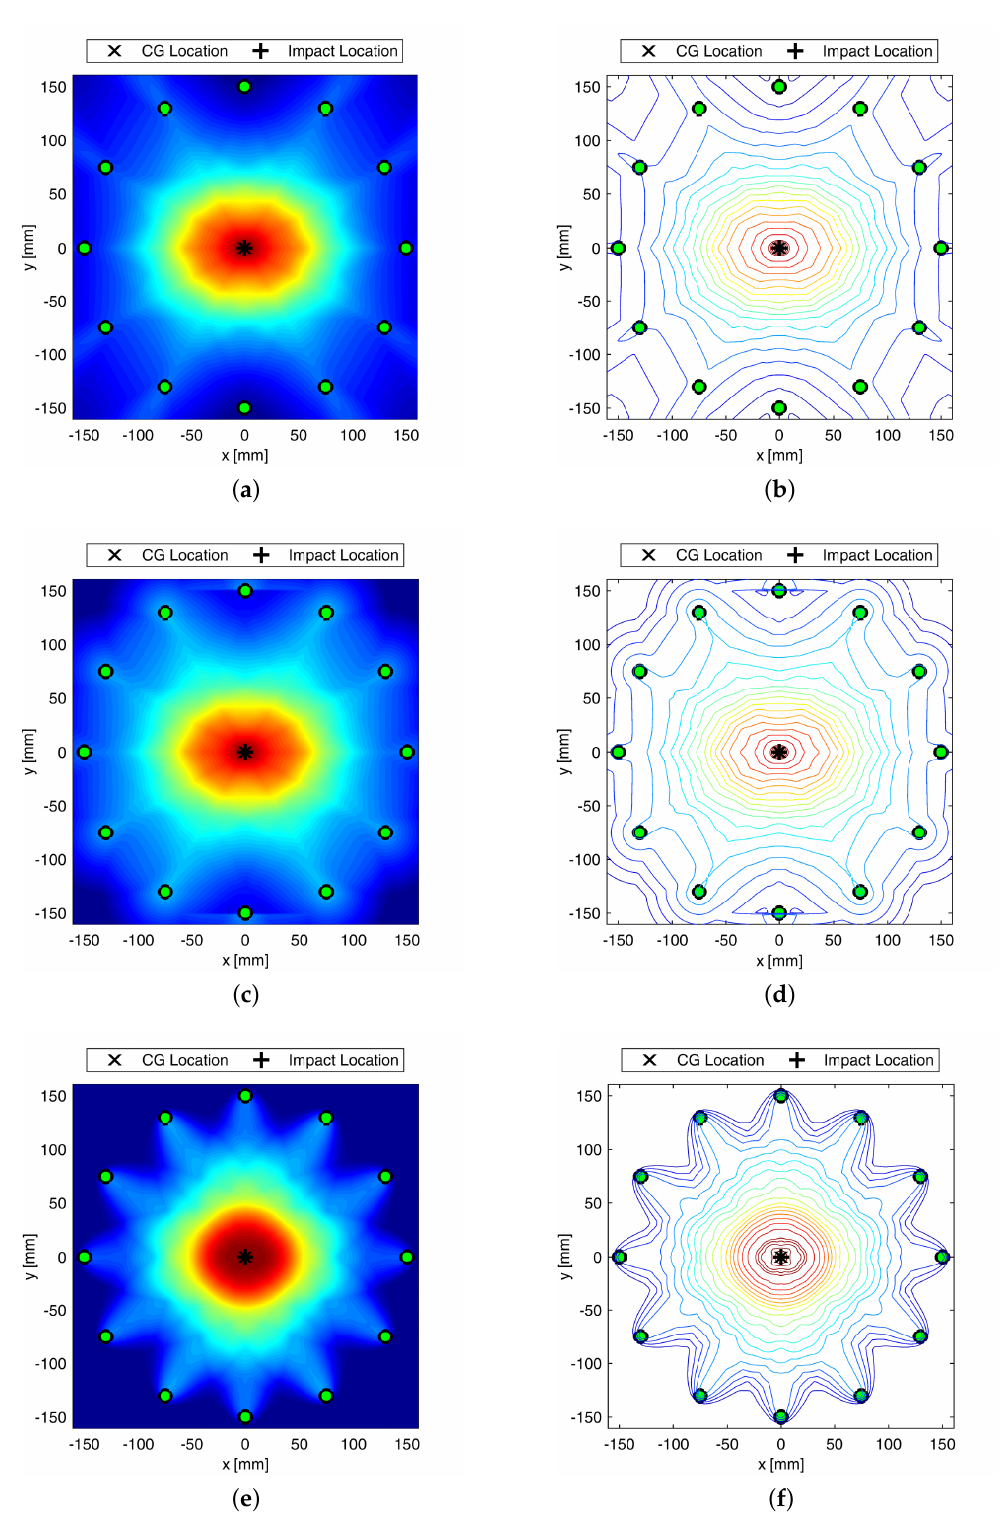
Figure 7. Maps of Damage Probability Index relying on energy based index. Damage map and contour plot using linear ( a , b ), modified linear ( c , d ), and elliptical ( e , f ) weight distribution function. Colorbar in between 0 and 1. SHM carried out at 50